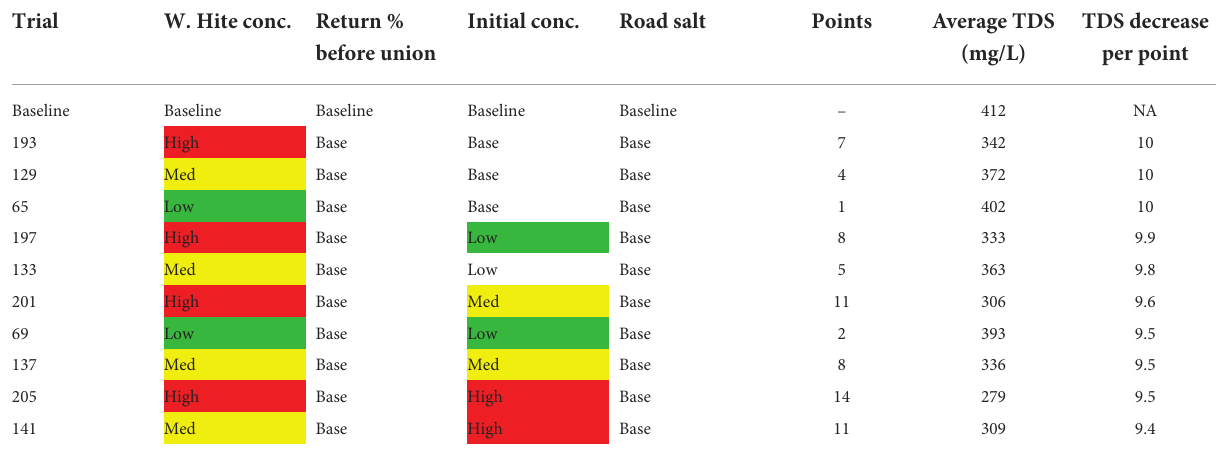
TABLE 1 Top 10 efficient urban salt management trials for the months April–October.